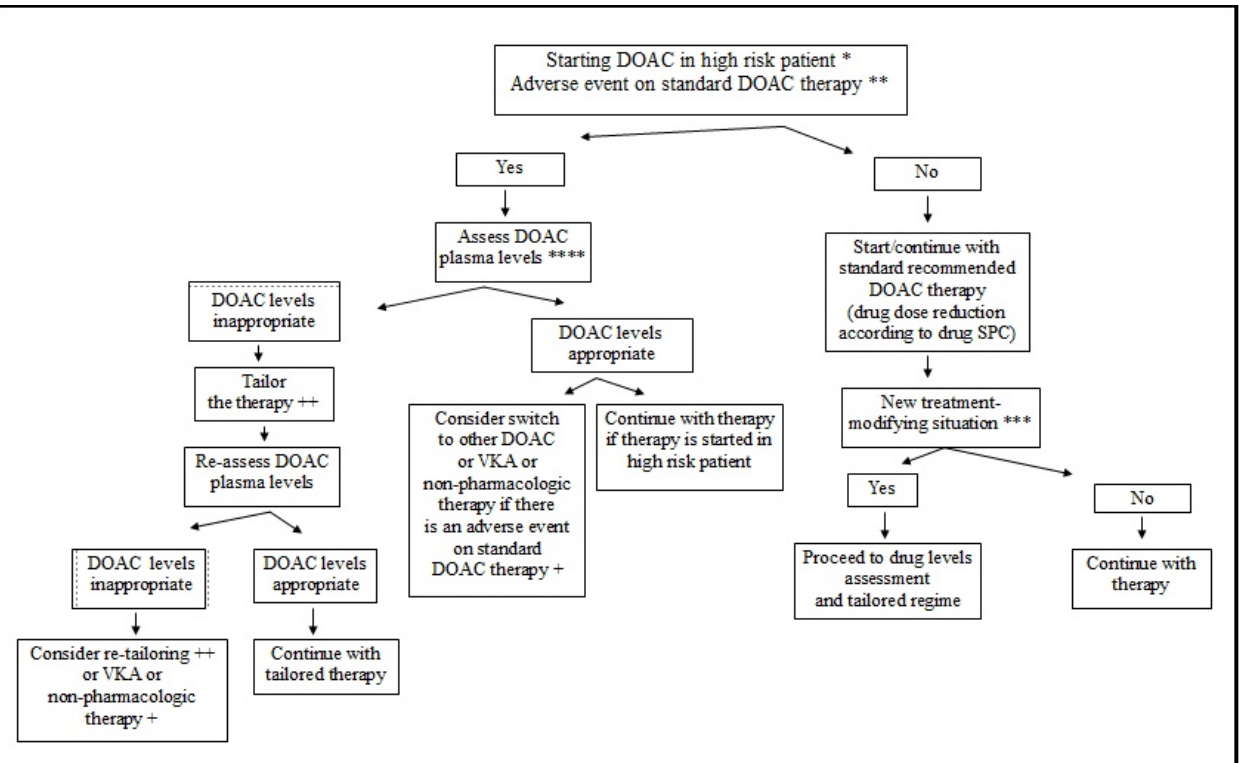
Figure 1. A proposed scheme for tailored direct oral anticoagulation. DOAC—direct oral anticoag- ulants; INR—international normalized ratio; LC-MS—liquid chromatography-mass spectrometry; SPC—summary of product characteristics; VKA—vitamin K antagonists. * severe renal/hepatic function impairment, extremely high body weight, advanced age, drug interactions. ** embolic stroke/systemic embolism or bleeding on labeled DOAC therapy. *** new adverse bleeding or thrombosis, new decrease in renal/hepatic function, new possible drug interaction, questionable pa- tient drug compliance. **** LC-MS (if available) or drug-specific coagulation assays; test for trough (pre-drug dose) and peak (post-drug dose) levels. + VKA with target INR 2-3 or left atrial appendage (surgical/transcatheter) occlusion. ++ by optimizing drug dose or switch strategy or by modification of (modifiable) factors influencing DOAC drug levels.